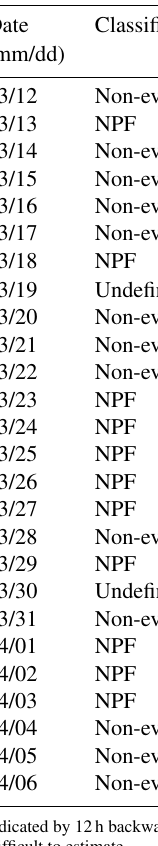
Figure 1. Contour of measured particle size distributions during 12 March to 6 April. The identified 13 non-event days and 2 undefined days are shadowed by grey and yellow background, respectively. Table 1. Characteristics of each campaign